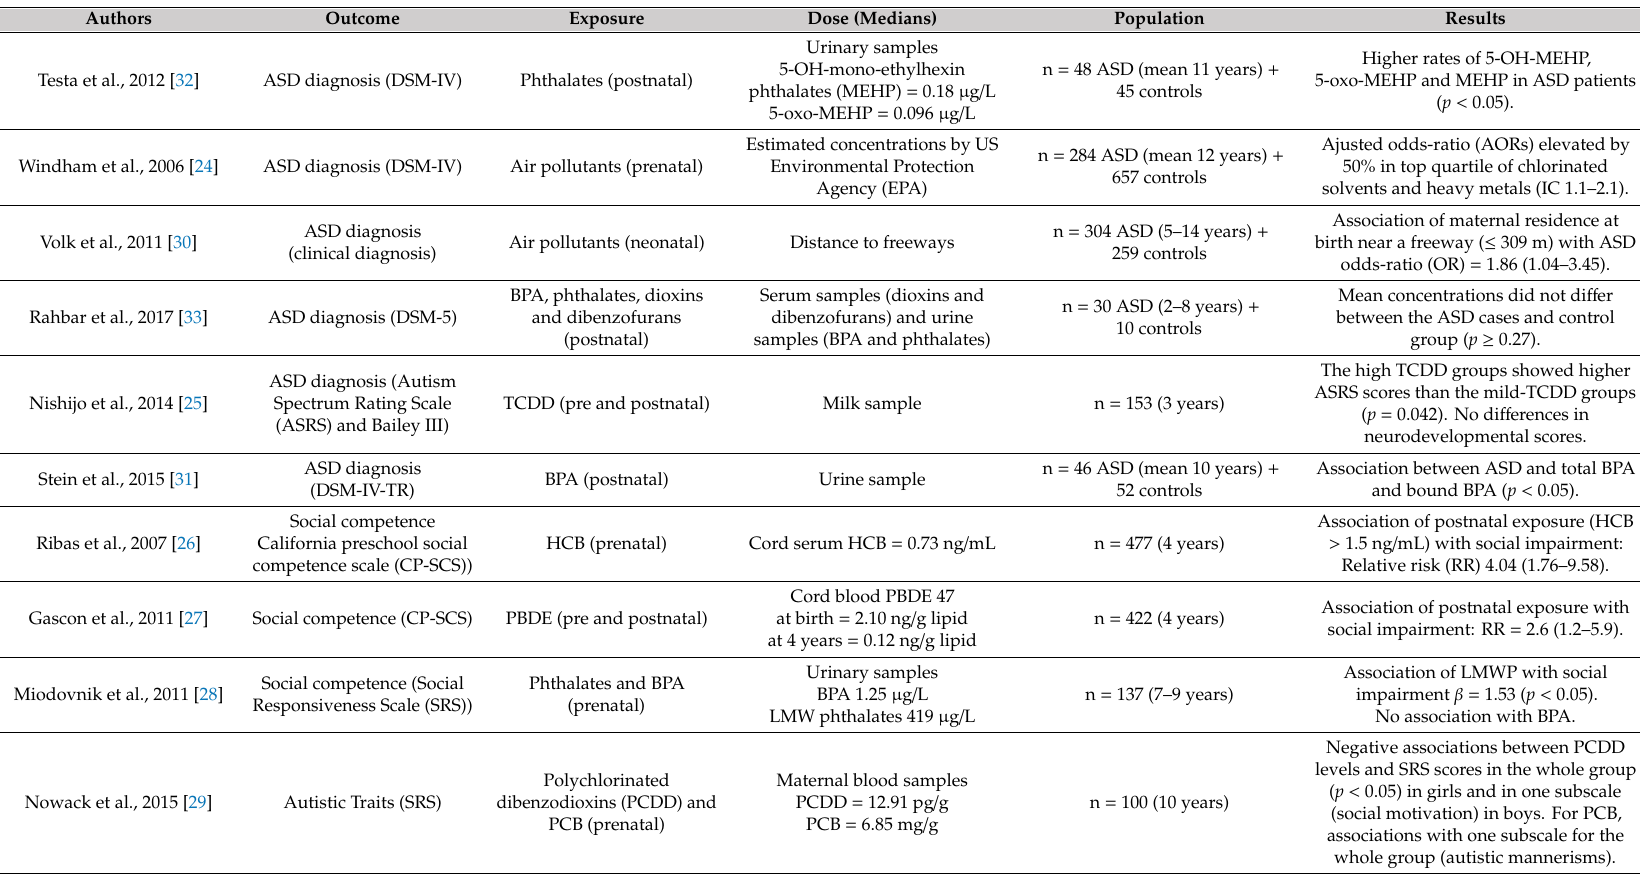
Table 1. Endocrine disruptors and autism spectrum